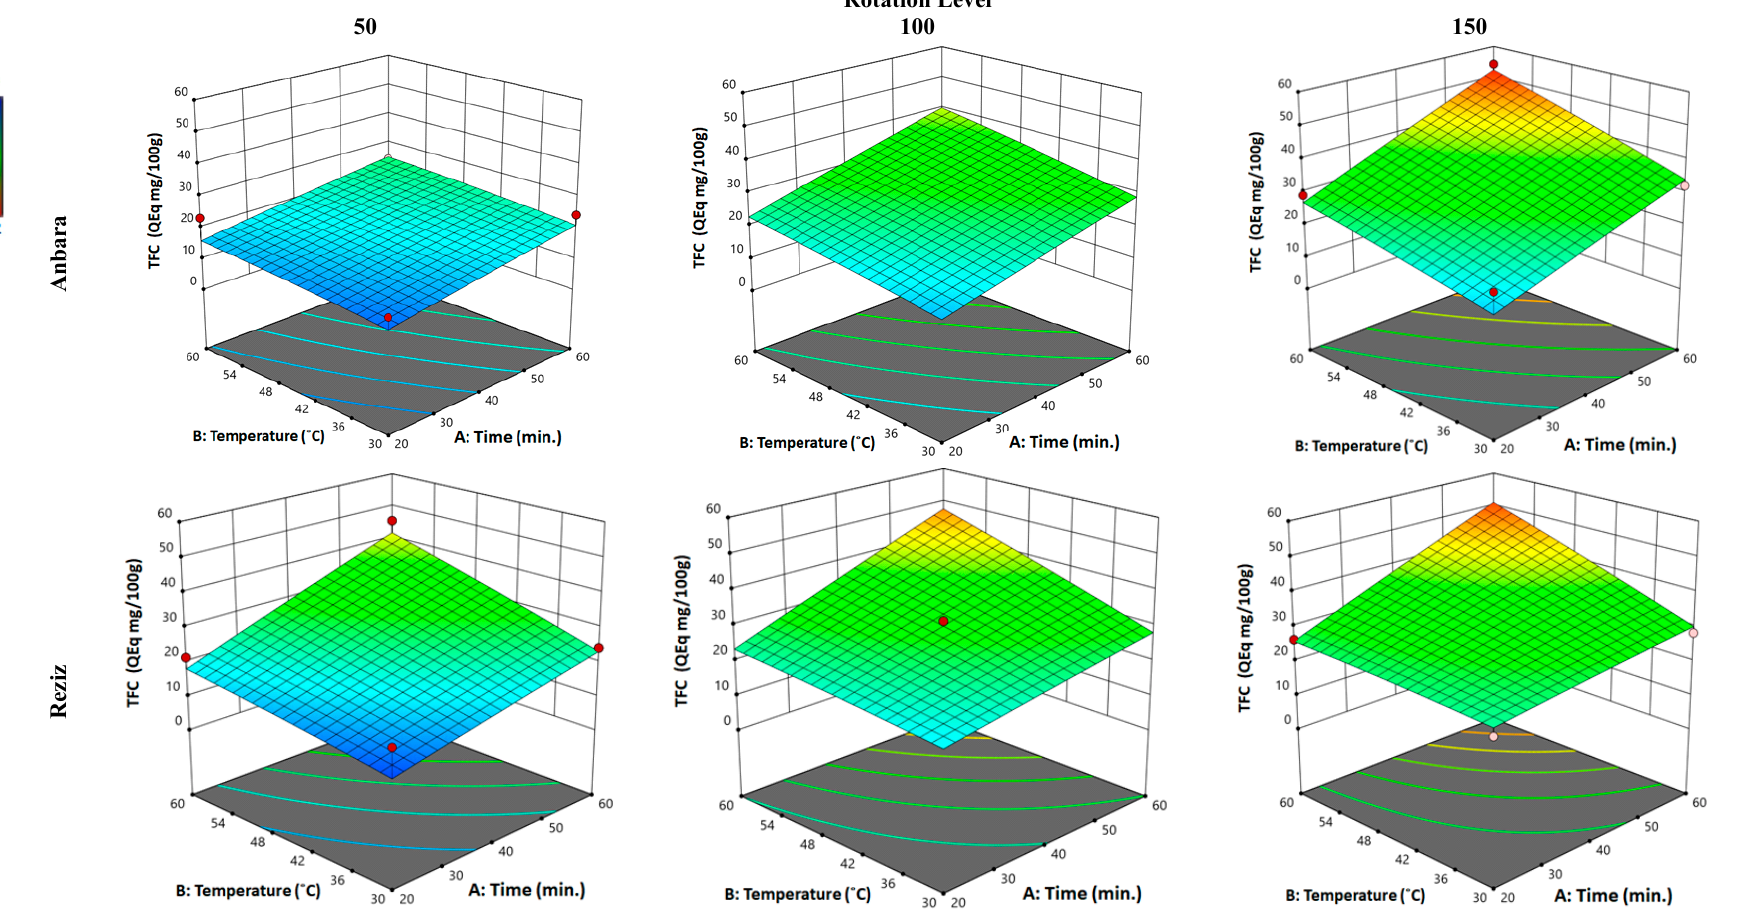
Figure 2. Three-dimensional response surface plot for the “response” variable: (total flavonoid content (TFC)), as a function of WAE “factors”: temperature, time, and rotation in two date palm fruits cultivars, Anbara and Reiziz.